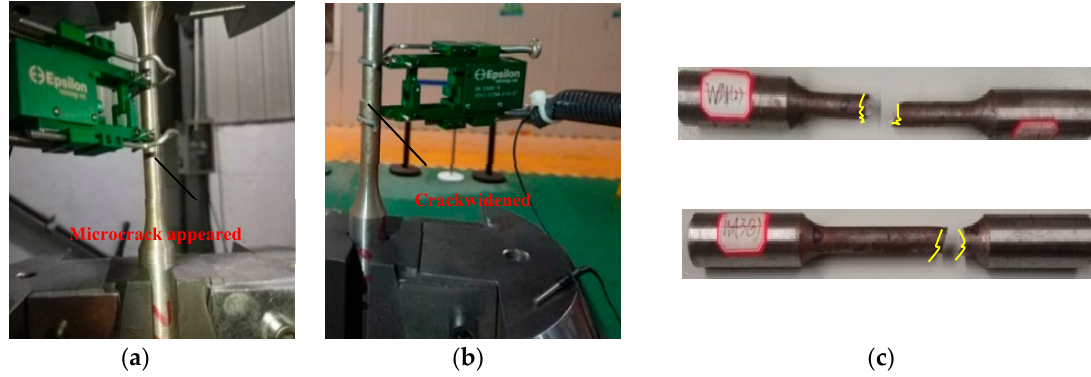
Figure 5. Damage process of welded specimen in low cycle fatigue test. ( a ) Crack appeared in specimen; ( b ) Crack develop; ( c ) Specimen fractured at the maximum main crack.